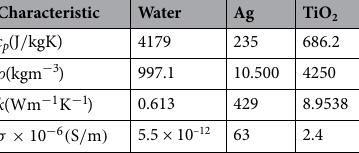
Table 2. Thermophysical properties of hybrid nanofluid 39 .